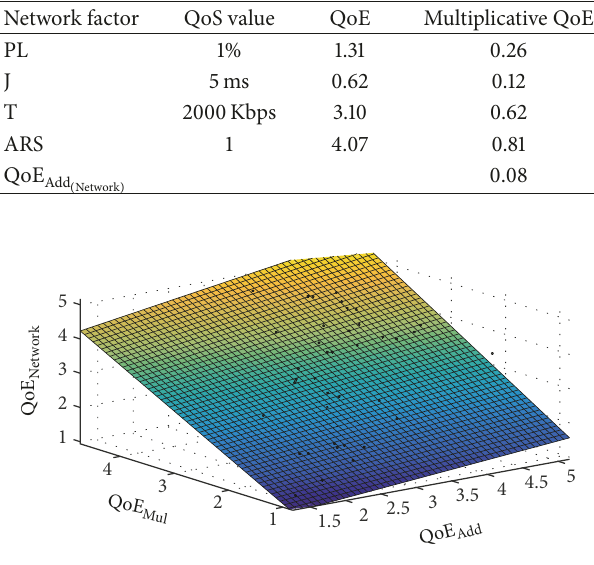
Figure 11: Network video